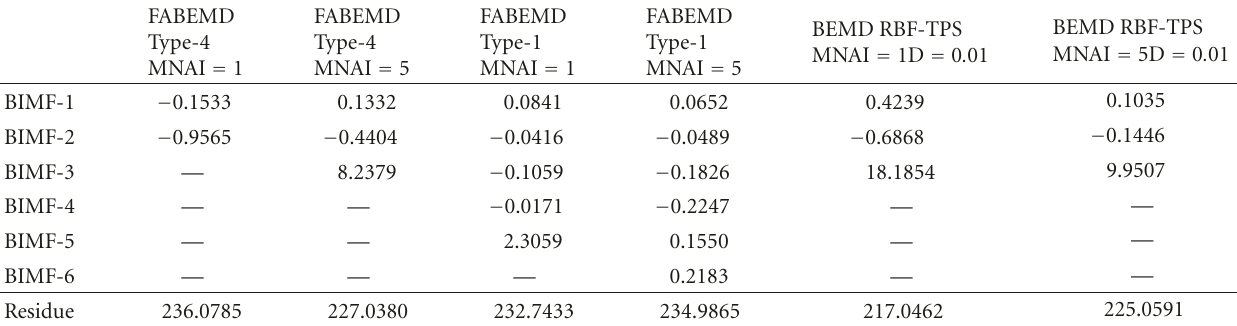
Table 4: Comparison among various FABEMD/BEMD for the STI in terms of global mean of the BEMCs. FABEMD